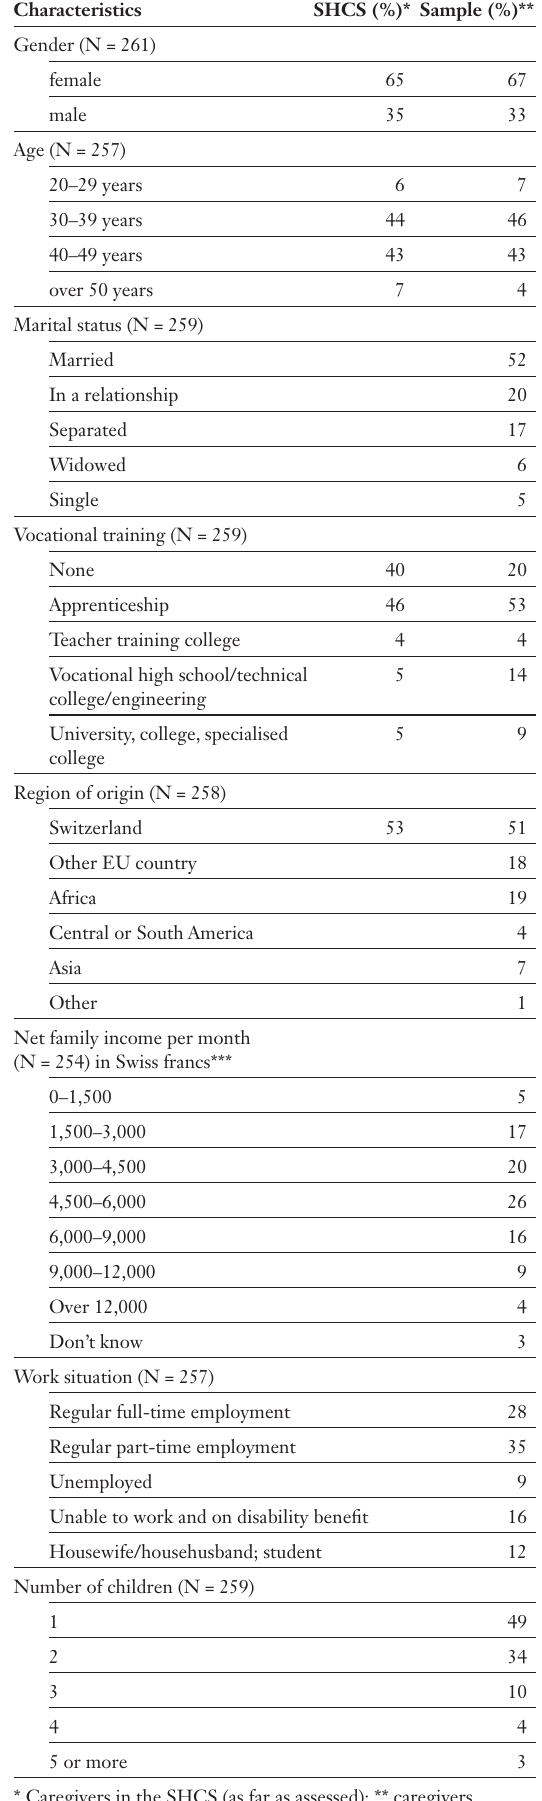
Demographic characteristics of the caregivers living with HIV.